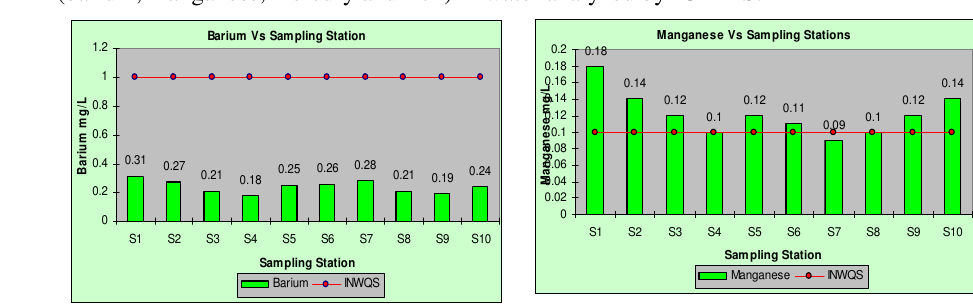
Figure 11. Barium vs. Sampling Station. Figure 12. Manganese vs. Sampling Station.